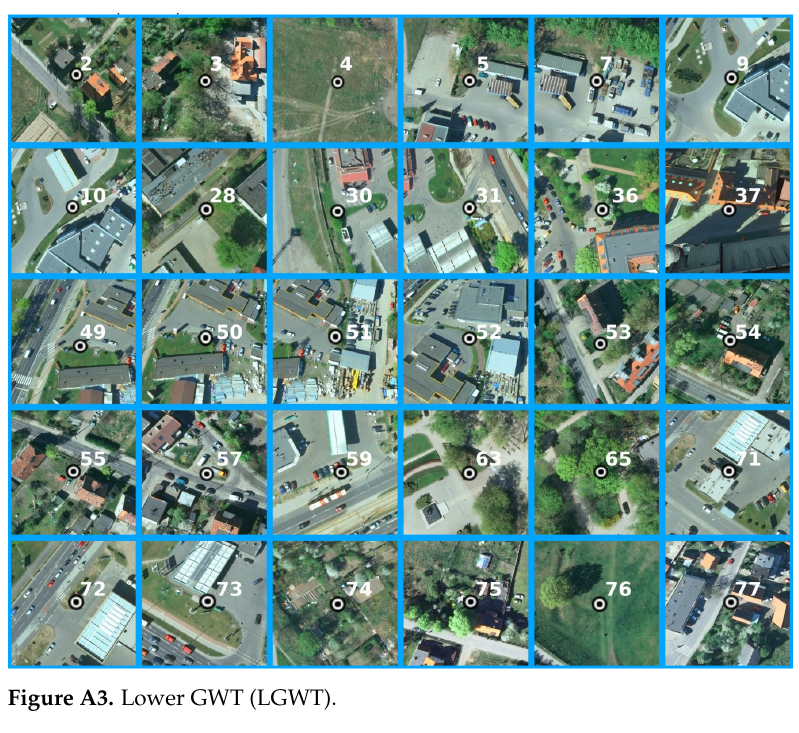
Figure A3. Lower GWT (LGWT).